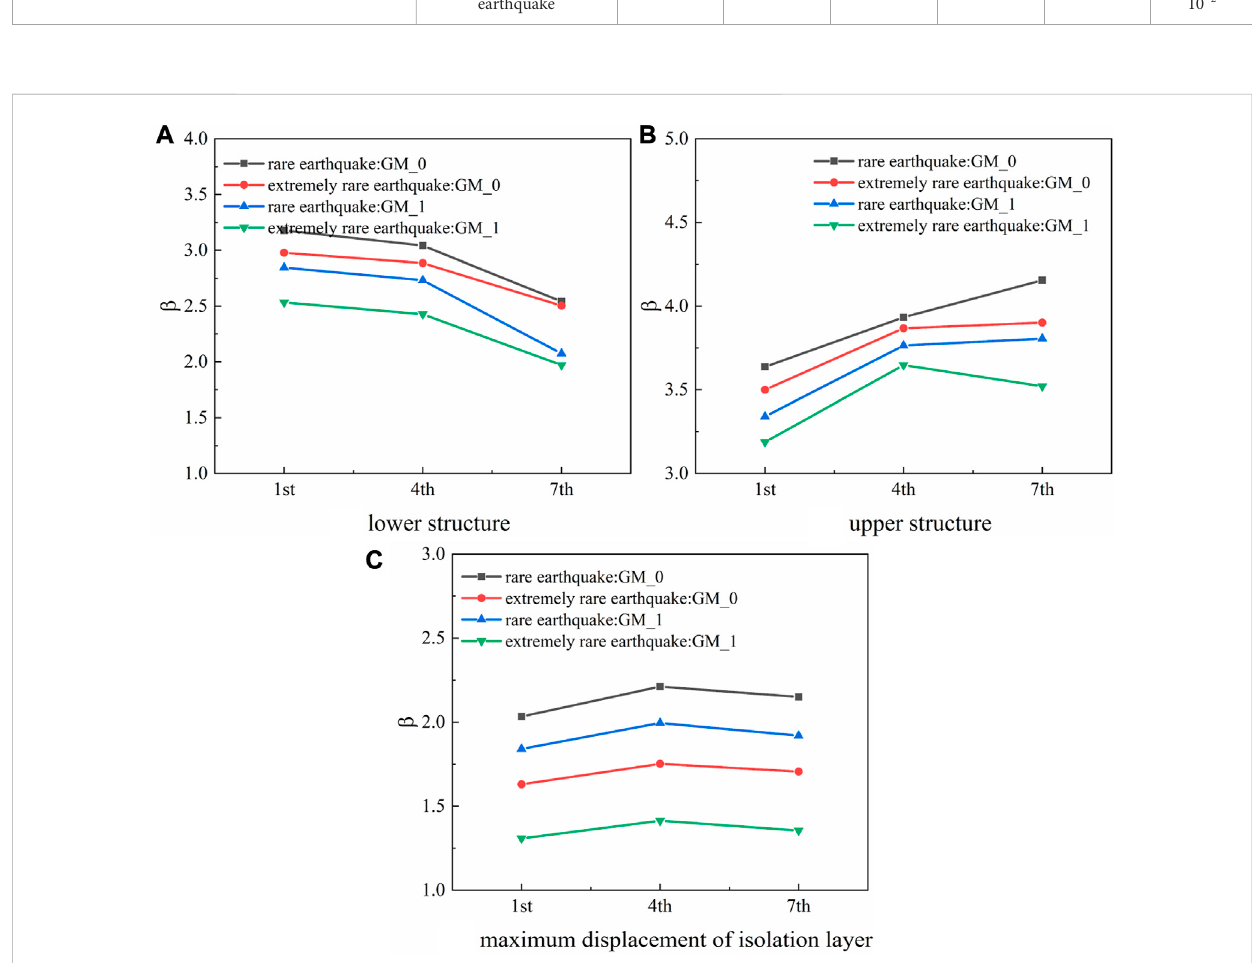
Comparison of failure probability with different isolation layer